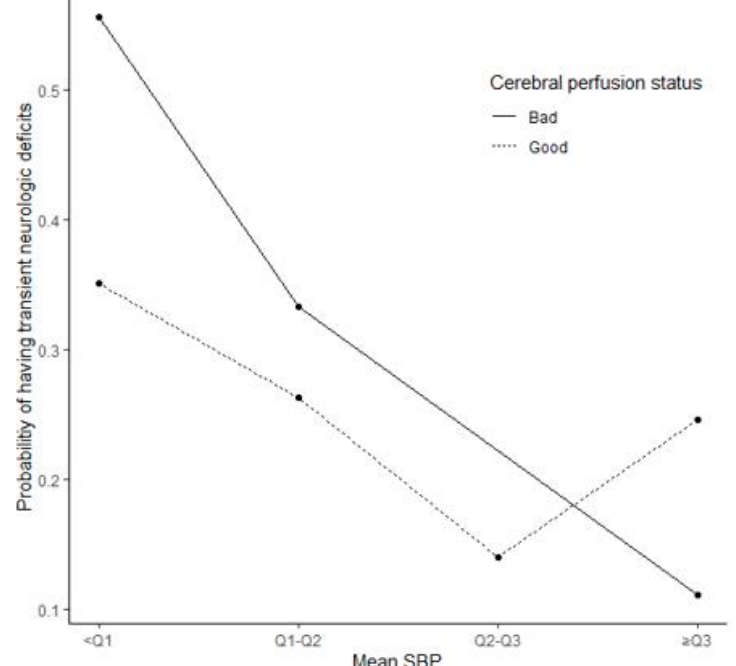
Figure 1. Proportion of transient neurologic deficits across quartile group of mean systolic blood pressure (SBP). Poor perfusion was defined as cerebral perfusion within a lower color range on basal SPECT compared with contralateral side and/or the surrounding area, while good perfusion status detected on brain SPECT images was classified as “normal” according to visual assessment by two nuclear medicine physicians.